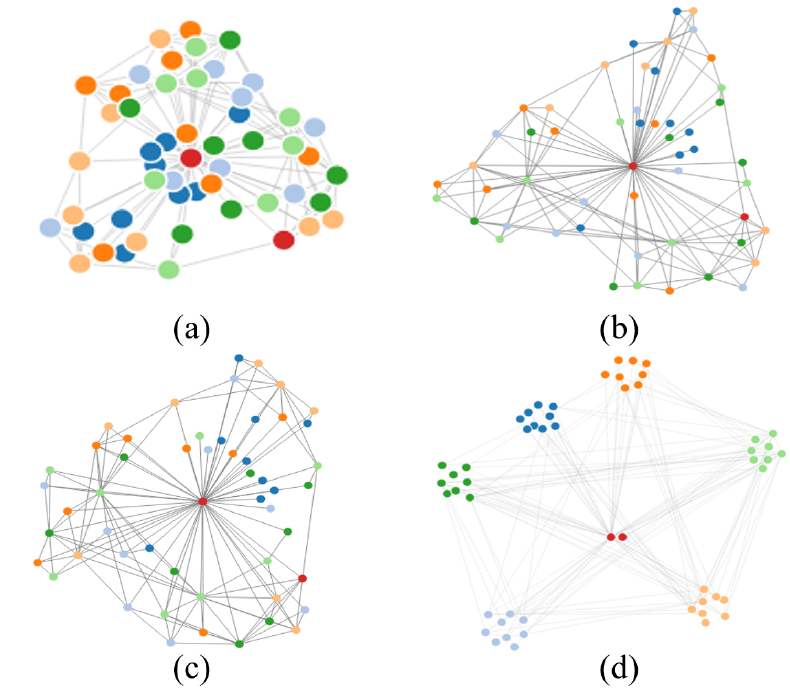
Figure 8. The result of attribute community layout under the attribute ‘working years’. ( a ) FR layout; ( b ) LinLog layout; ( c ) ForceAtlas2 layout; ( d ) layout of our method.